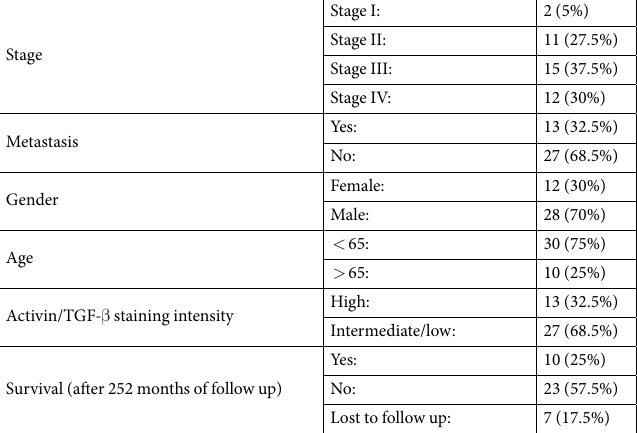
Table 2. Epidemiologic data of colorectal cancer TMA by Imgenex (San Diego, CA). Cohort data from commercial CRC tumor micro-array (TMA) including tumor stage, whether the subject had metastases, gender, age, length of survival, and activin and TGF- β combined staining